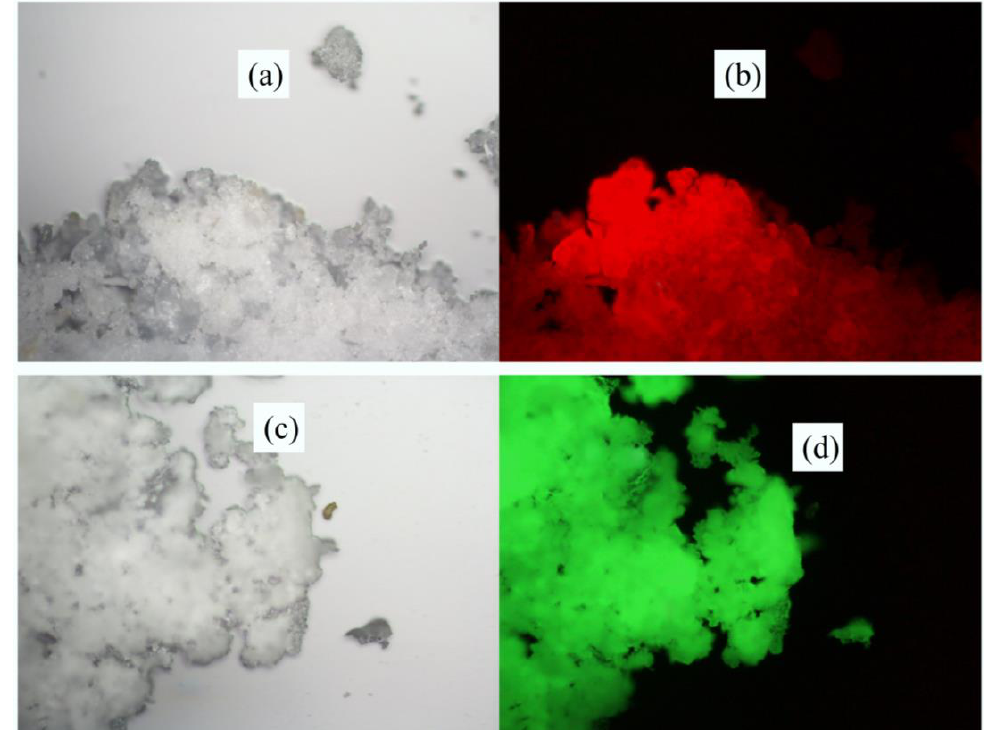
Figure 3. Photos of polycrystalline powders K-NMI-Eu and K-NMI-Tb exposed to ultraviolet light ( λ = 330–380 Nm) under ambient lighting in a room ( a , c ) and at indoor temperature ( b , d ). Adapted with permission from ref. 27. Copyright 2019 Science Direct.